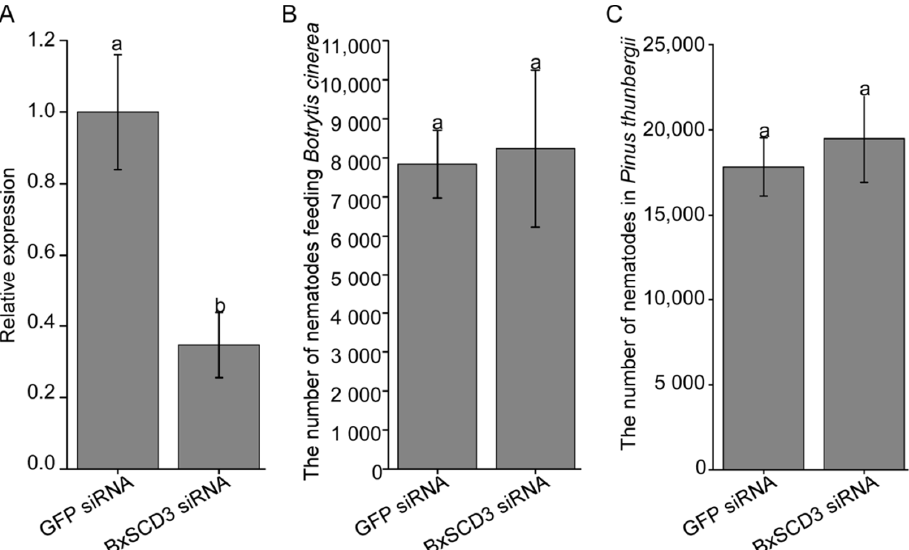
Figure 5. BxSCD3 does not affect Bursaphelenchus xylophilus reproduction. ( A ) The silencing efficiency of BxSCD3 was measured by quantitative real-time polymerase chain reaction (RT-qPCR). ( B ) The number of BxSCD3 siRNA-treated nematodes after inoculation into Botrytis cinerea for 5 days (d). ( C ) The number of BxSCD3 siRNA-treated nematodes after inoculation into Pinus thunbergii for 25 d. The GFP siRNA-treated nematodes were used as a control in the above three independent experiments. Data are the means, and the error bars represent ± SD from three biological replicates. Different letters on top of the bars indicate statistically significant differences ( p < 0.05, t ‐ test) as measured by Duncan’s multiple range test.